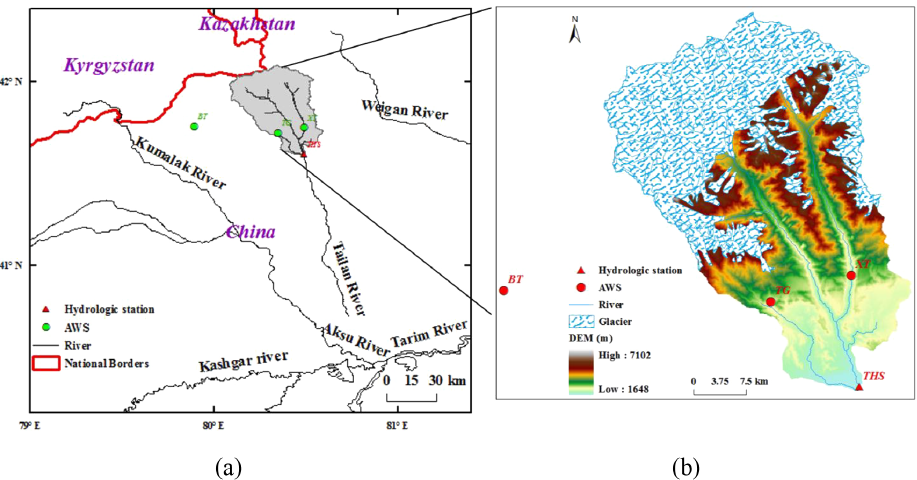
Figure 1. Location of the Tailan River basin in the Xinjiang Uygur autonomous region, China. Two automatic weather stations (TG is the Tagelake automatic weather station (AWS) at 2381ma.s.l. and XT is the Xiaotailan AWS at 2116ma.s.l.) were set up in an upstream mountain area in July 2011. Additionally, the BT is the Bingtan AWS (3950ma.s.l.) located in the adjacent Kumalak River basin was used to validate the estimated temperature lapse rates. The Tailan hydrologic station (THS) has gauged streamflow data at the catchment outlet since 1957 (a) . Glacier occupies approximately 33% of the total basin area (b)